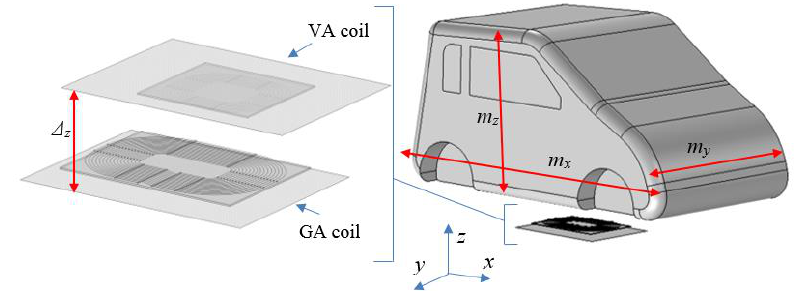
Figure 7. Computer-aided design (CAD) model of the modeled SAE J2954 coils and of the city car body with the WPT coil system.